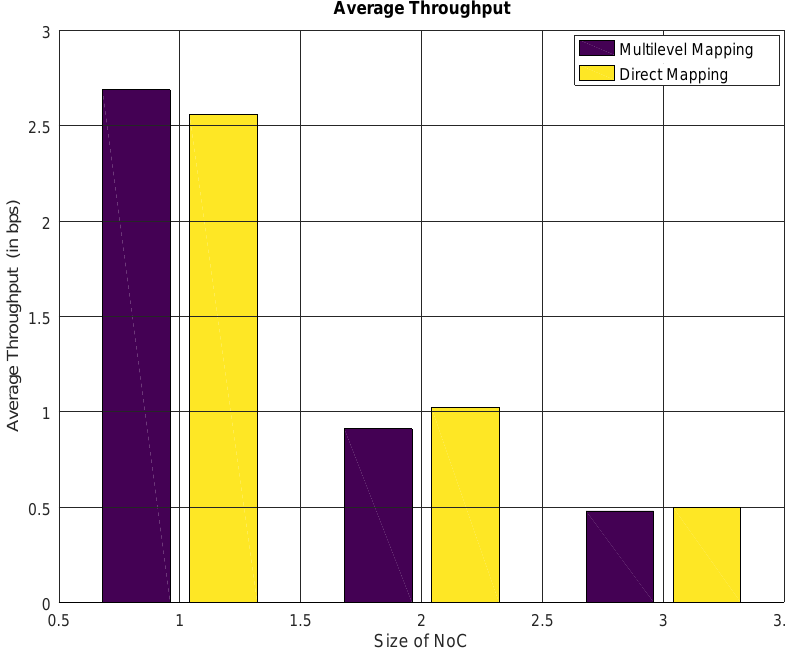
Figure 17. Average